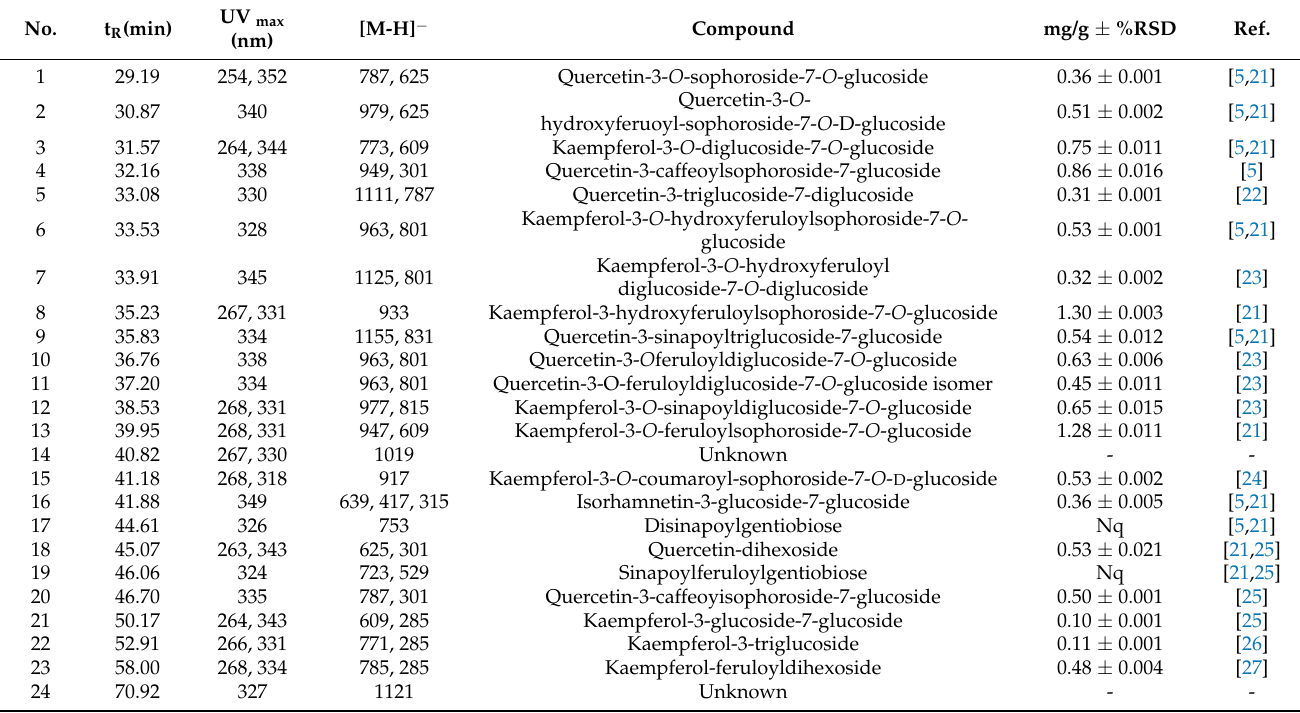
Table 1. HPLC-PDA/ESI-MS (negative ionization mode) polyphenolic fingerprint of B. fruticulosa subsp. fruticulosa leaf hydroalcoholic extract. Results are expressed as mg/g extract ± SD ( n =